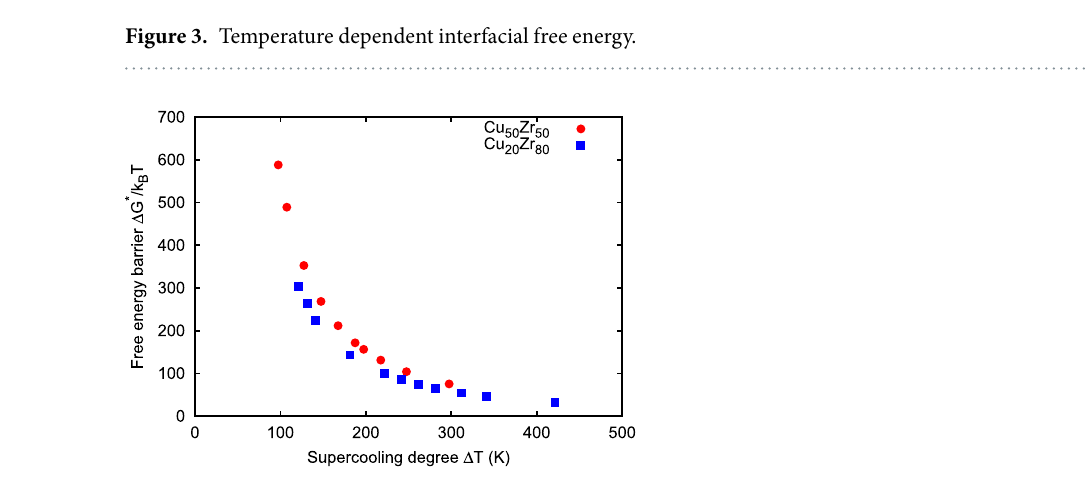
Figure 4. Nucleation free energy barrier as a function of Δ T .